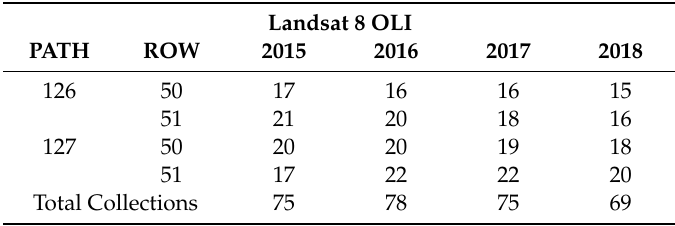
Table 1. Landsat 8 Operational Land Imager (OLI) collections used for assessing the phenological behavior of selected land cover categories.